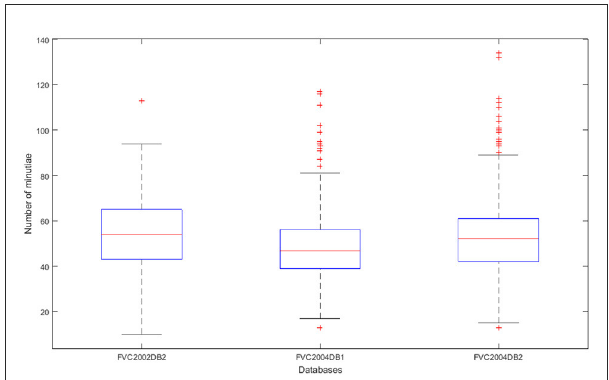
FIGURE3 Distribution of the number of minutiae contained in each template per database by box whiskers.